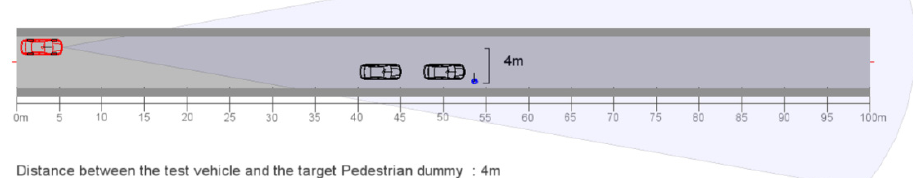
Figure 12. Euro NCAP VRU-Pe scenario.